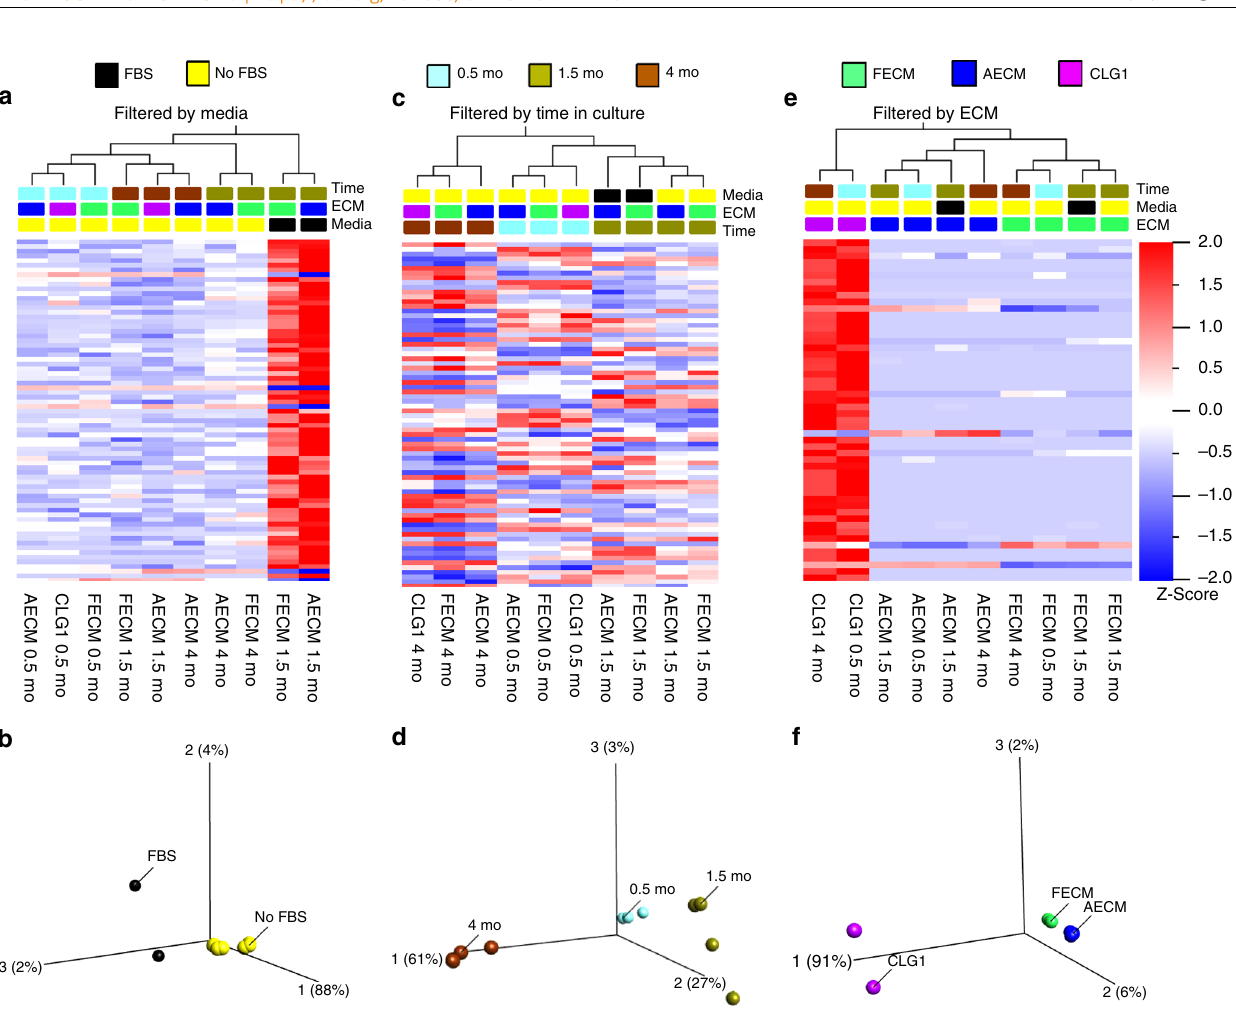
Fig. 3 RNA-sequencing data for anaplastic ependymoma 3D bioengineered cultures. a – c Heatmap along with cluster dendrograms focusing on time in culture, media type and extracellular matrix categories, respectively, generated using FPKM (Reads Per Kilobase of transcript per Million mapped reads) values with a false discovery rate q < 0.2 or p -values < or = 0.005. d – f Principal component analysis (PCA) plots corresponding to a , b and c clustering, respectively. FECM- Fetal ECM + collagen I, AECM- Adult ECM + Collagen I, CLG1-Collagen I. a , b : False discovery rate (q) = 0.04, p- value = 0.001; c / d : q = 0.04, p = 0.005; e , f : q = 0.2, p = 0.0002; n = 1 per condition. Source data are provided as Supplementary Data